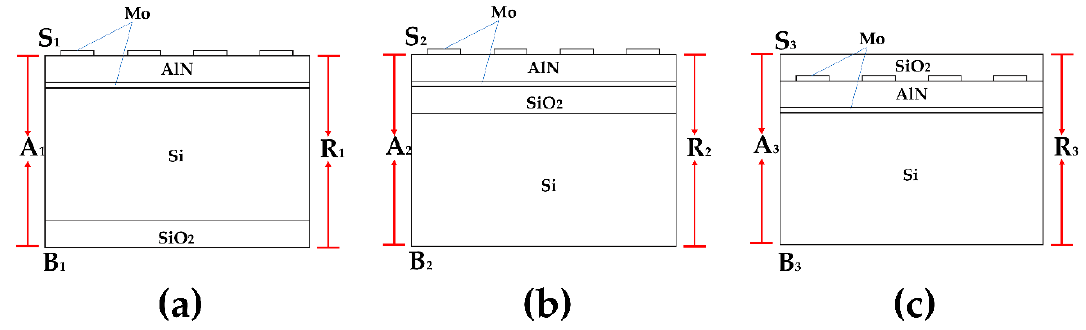
Figure 4. One unit of 2D resonator simulation models with periodic boundary conditions, ( a ) the oxide layer in the bottom of Silicon layer, ( b ) the oxide layer between the Silicon and AlN layer, ( c ) the oxide layer on the top layer. Table 2. Materials constants used in the simulation.